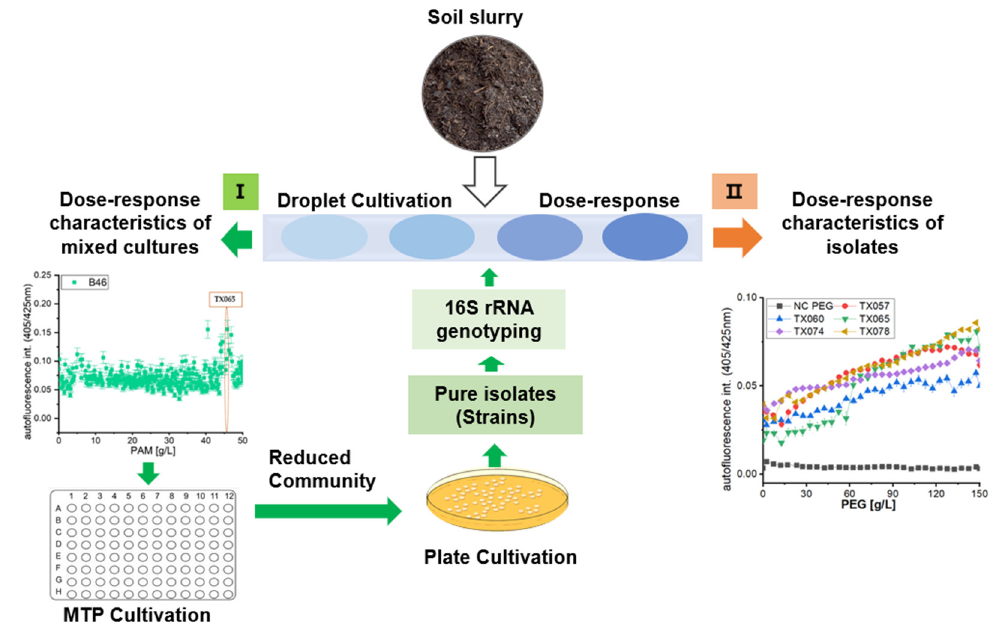
Figure 1. Microfluid cultivation, isolation, and characterization of soil